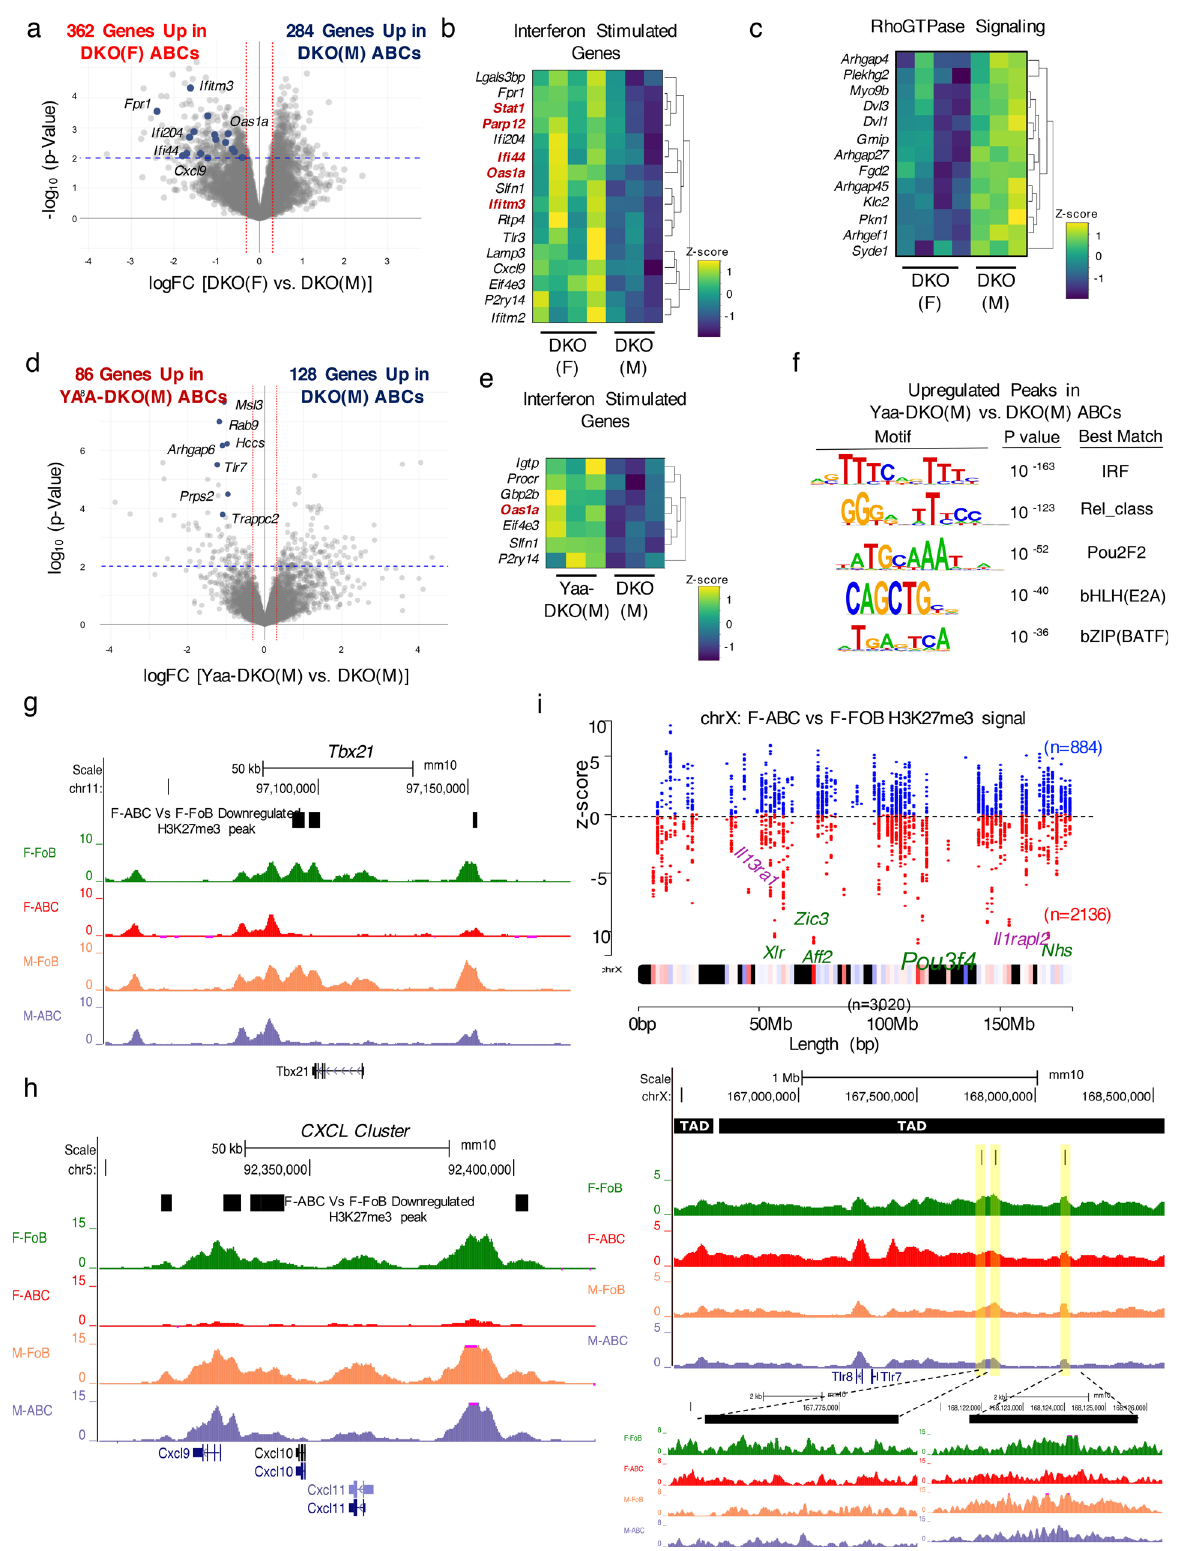
Supplementary Fig. 5D). In line with the notion that inter- mediate expression of BCL6 protein in B cells has been asso- ciated with a pre-GC B cell state 38 , the CD11c + population contained increased frequencies of BCL6 mid IRF4 + B cells, a pro fi le associated with pre-GC B cells, and was enriched in a pre-GC B cell signature by GSEA (Fig. 5d, e). BCR signaling,